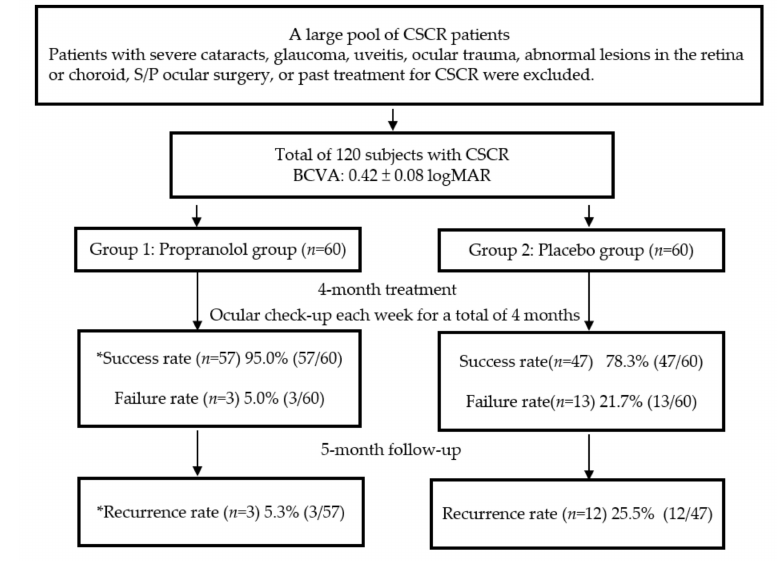
Figure 1. The flow chart shows the designed protocols and final results, divided into groups 1 and 2, during the whole 9 months of our study. * denoted a significant di ff erence between the propranolol and placebo